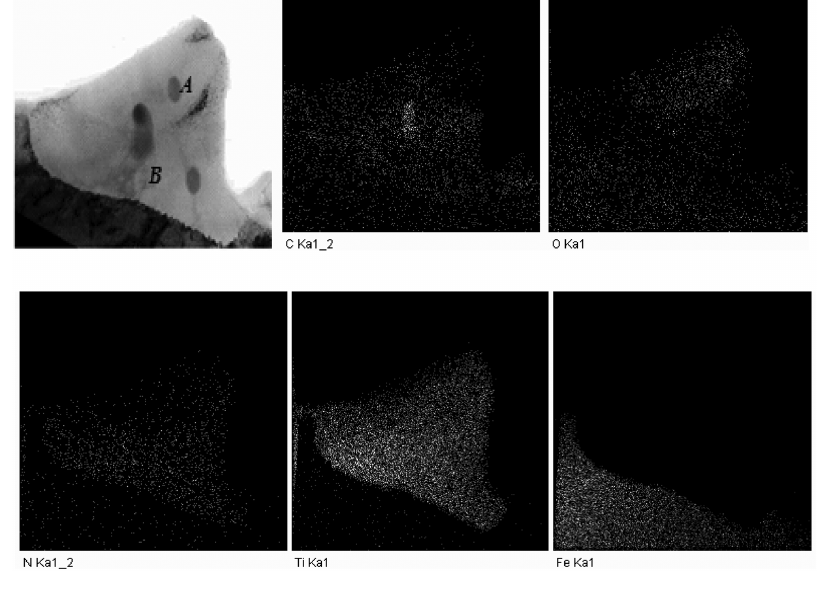
Figure 6: Element distribution in the composite core.